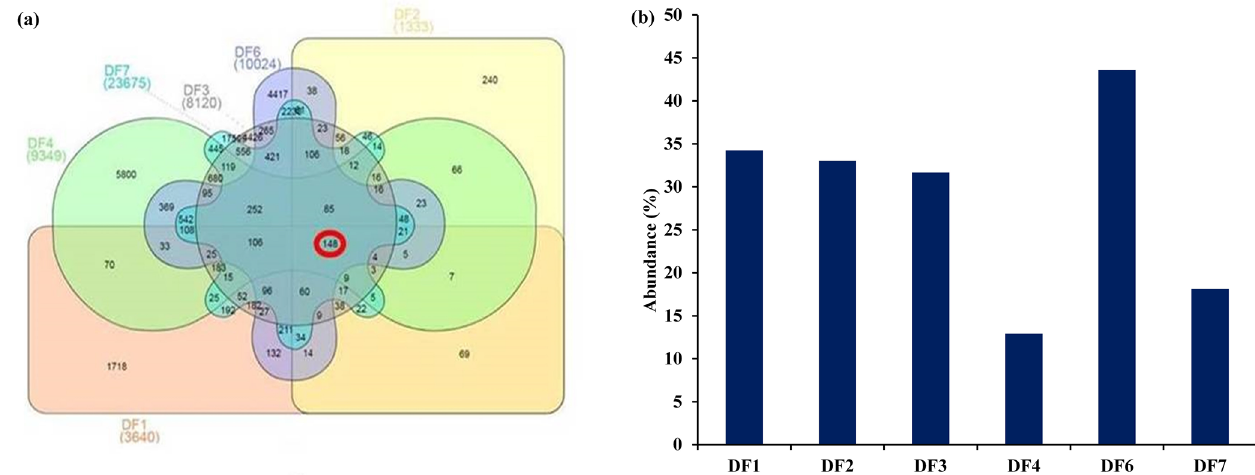
Figure 6. (a) Venn diagram displaying the number of common OTUs among the DF samples; 148 OTUs were found common in the DF samples (1–7). (b) Percentage abundance of common OTUs across the DF